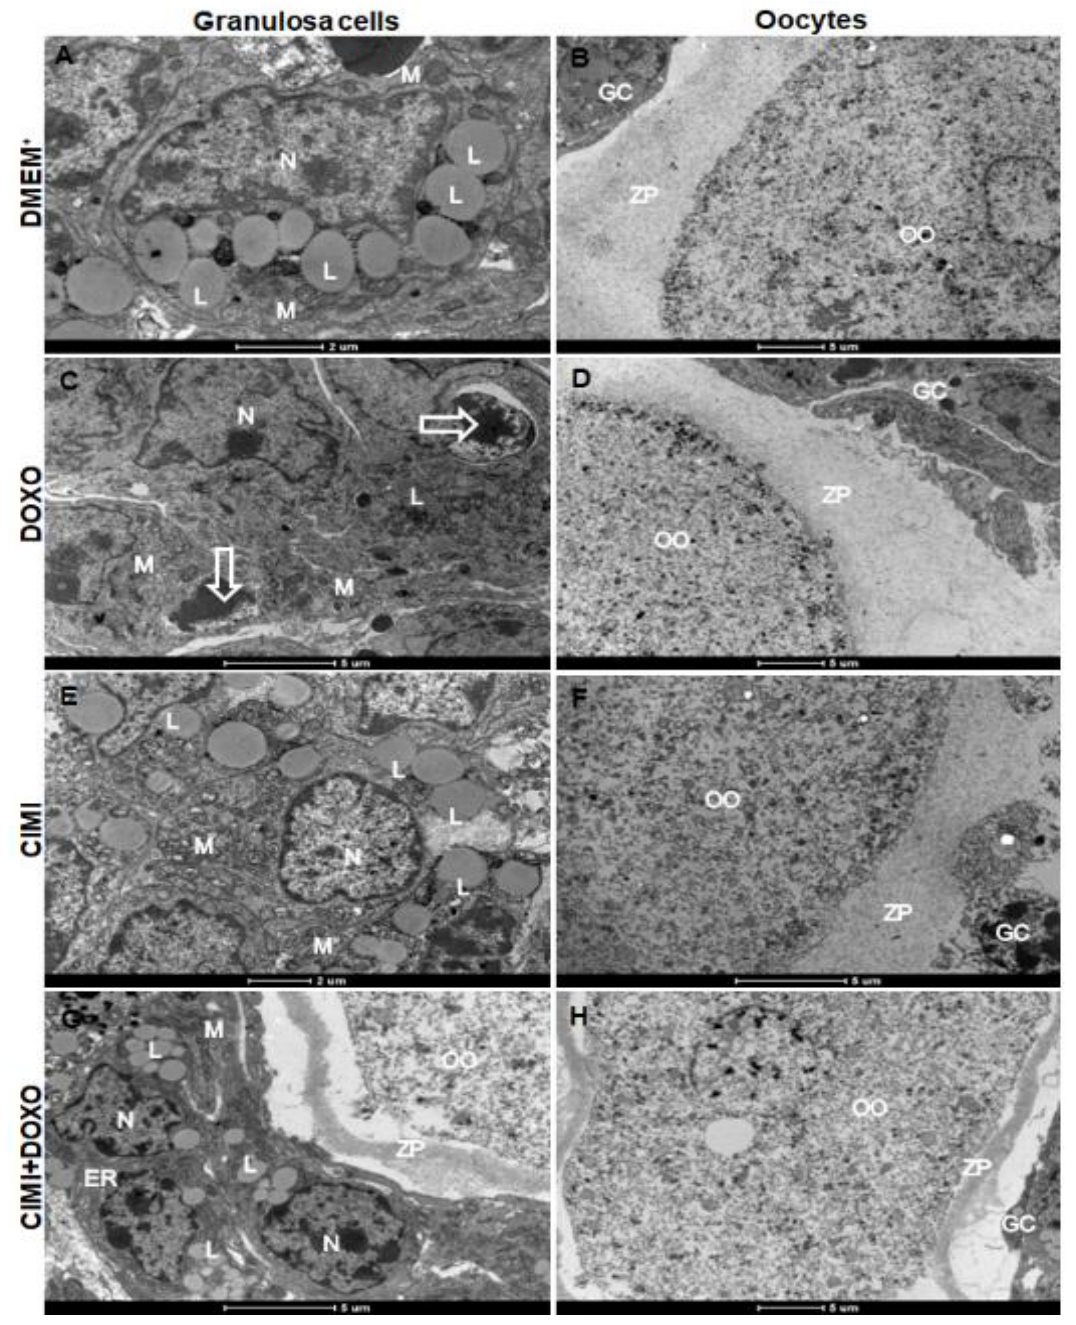
Figure 12. Representative micrographs of mice ovaries cultured for 6 days: ( A , B ) control group (DMEM + ); ( C , D ) DOXO (0.3 μg /mL); ( E , F ) CIMI (5 ng/mL) and ( G , H ) CIMI (5 ng/mL) + DOXO (0.3 μg /mL). M, mitochondria; N, nucleus; ZP, zona pellucida, L, lipid; OO, ooplasm; GC, granulosa cells; ER, endoplasmic reticulum.